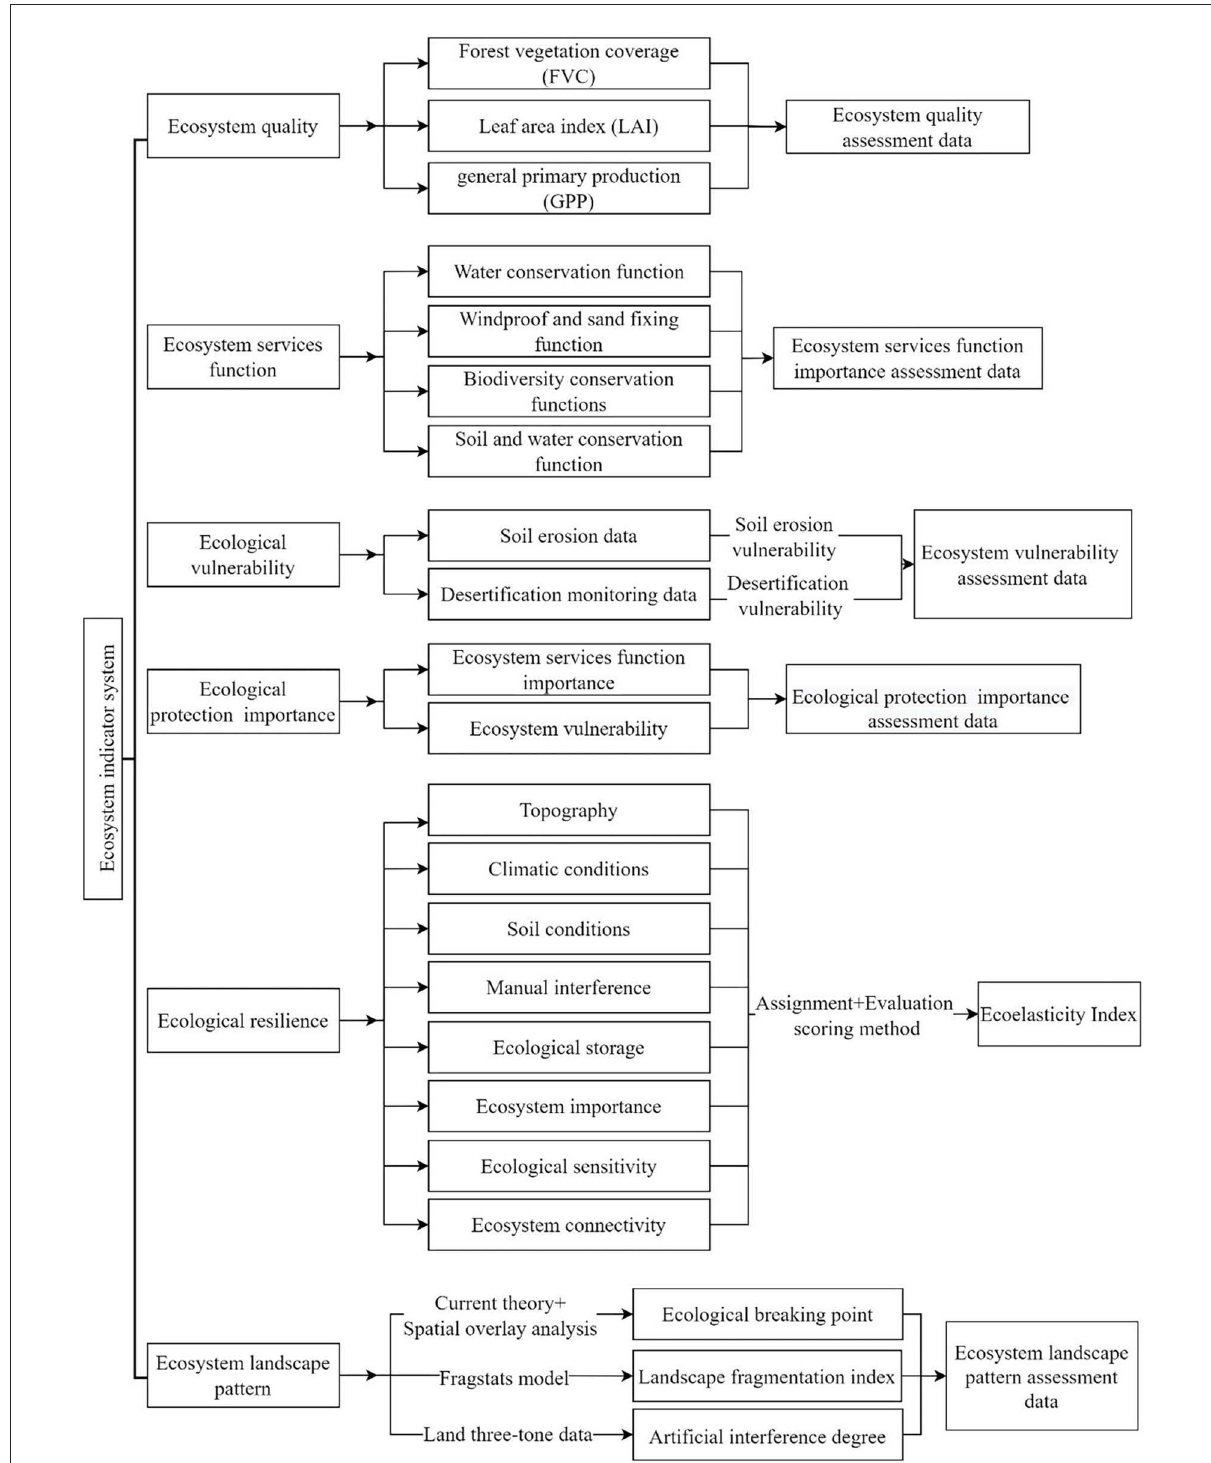
FIGURE9 Method of comprehensive ecosystem